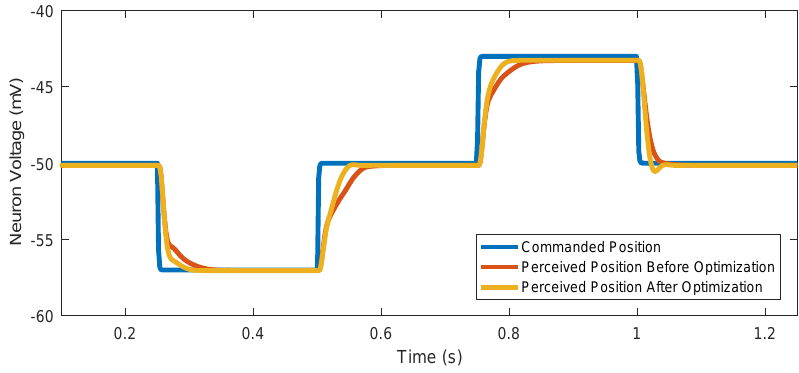
Figure 9. Optimizing parameters G syn , P , G syn , I , T max , ext , and T max , flx improves reference tracking. The commanded position trajectory is chosen arbitrarily.